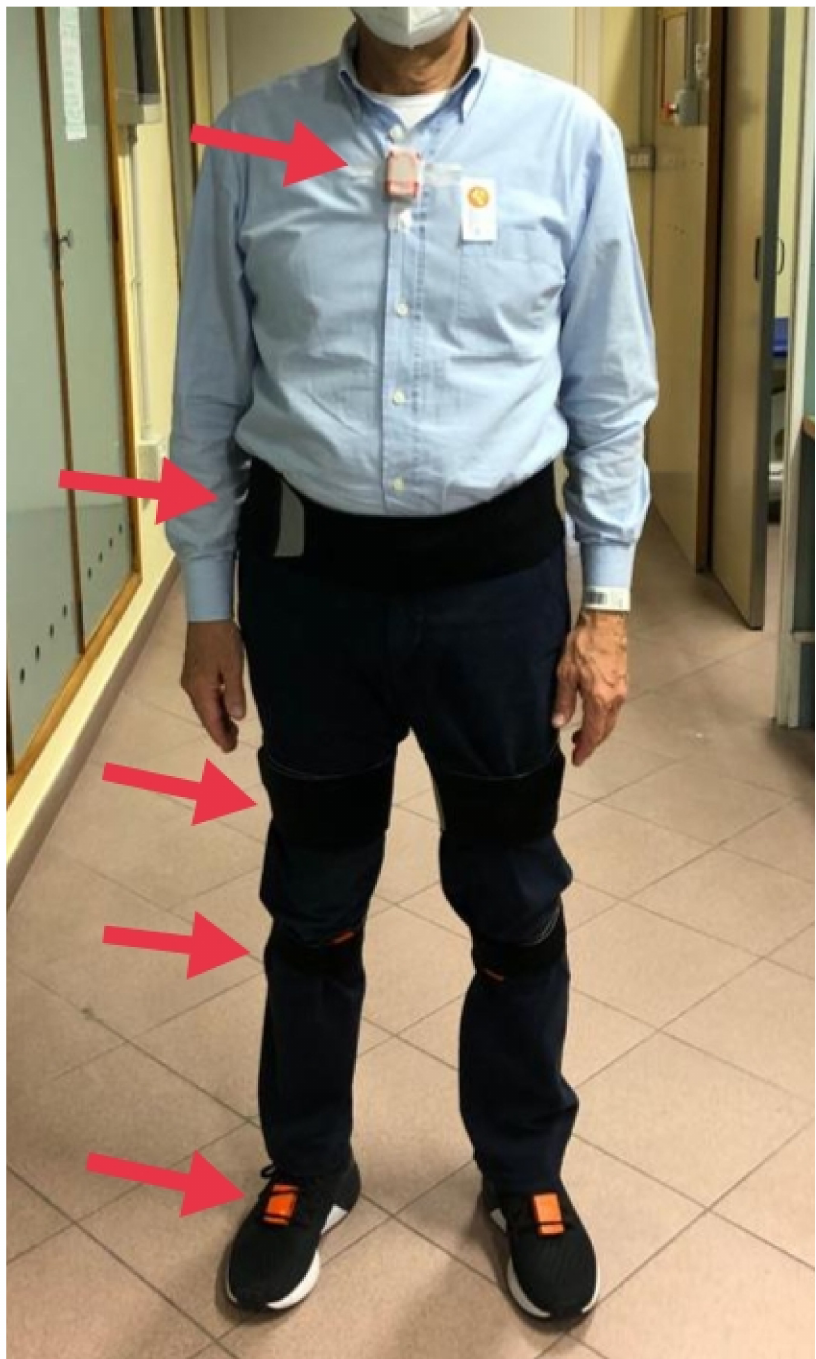
Figure 5. Positioning of the inertial motion